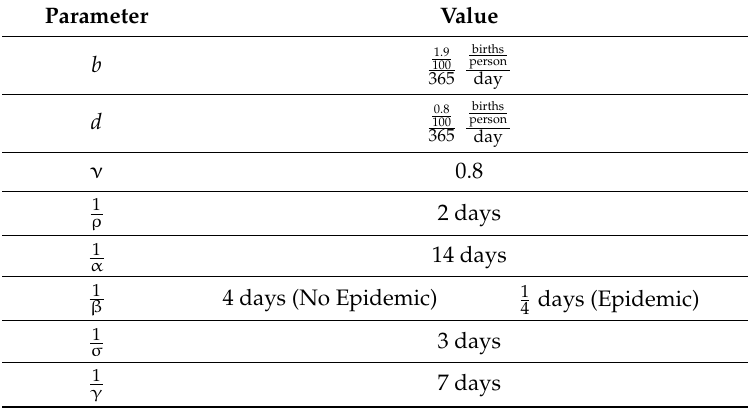
Table 4. Numerical Values of Model Parameters and Inverse Model